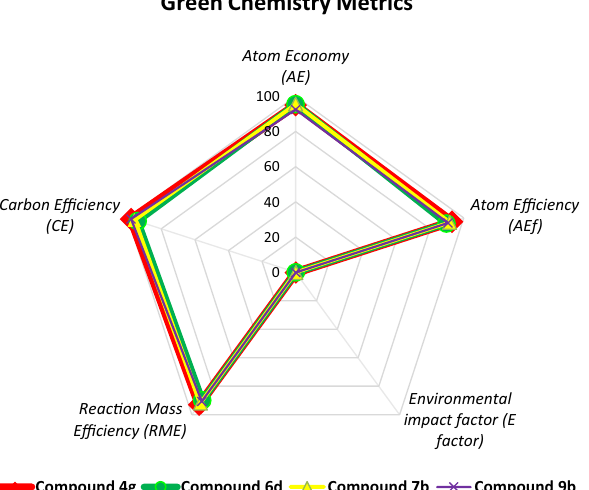
Figure 12. Radial pentagon diagram of green chemistry metrics calculation for the synthesis of 4g , 6d, 7b , and 9b by Brønsted acid catalyzed water-assisted grinding via a mortar and pestle at ambient